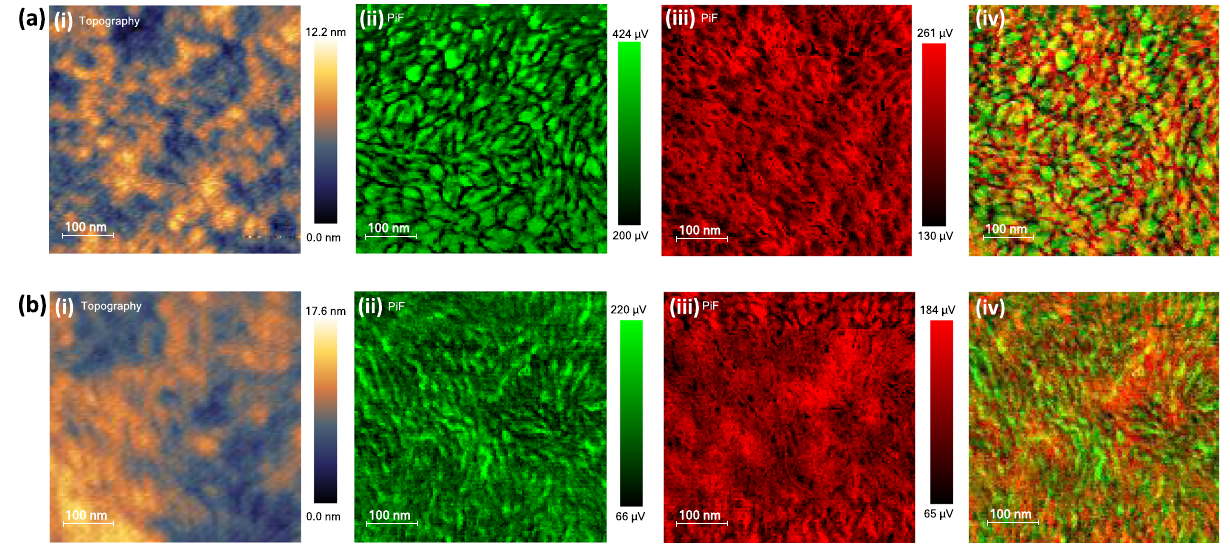
Fig. 4 AFM and PiFM images of the blend fi lms. a Patterns of PBDB-T:PN-Se blend. b Patterns of PBDB-T:PS-Se blend. (i) AFM topography images of corresponding blend fi lms. (ii) PiFM images of PBDB-T. (iii) PiFM images of the PSMA. (iv) Combined images of (ii) and (iii) to provide chemical map of PBDB-T and